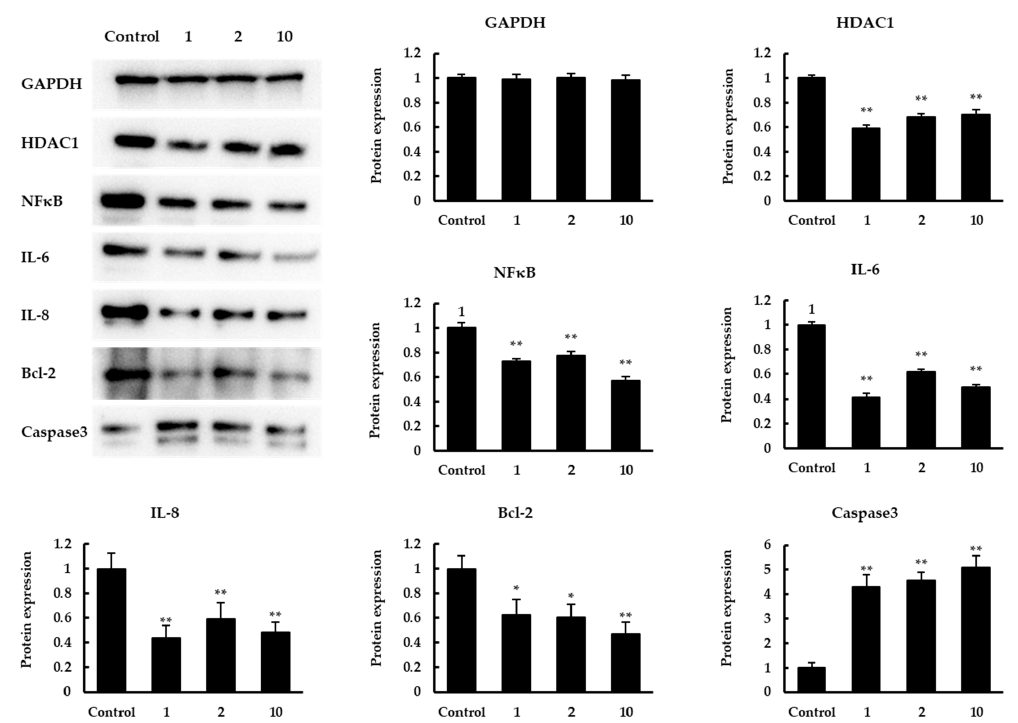
Figure 5. Western blot analysis. The effect of quinoa peptides 1, 2, 10 in protein levels of GAPDH, HDAC1, NF κ B, IL-6, IL-8, Bcl-2, caspase3. GAPDH was set as the loading control. Expression was normalized to GAPDH expression and shown in mean ± SD. * p < 0.05 and ** p < 0.01 versus control group.